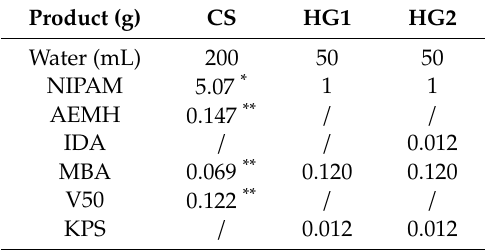
Table 1. Recipe of core-shell and nanohydrogel particles preparation. Product (g)